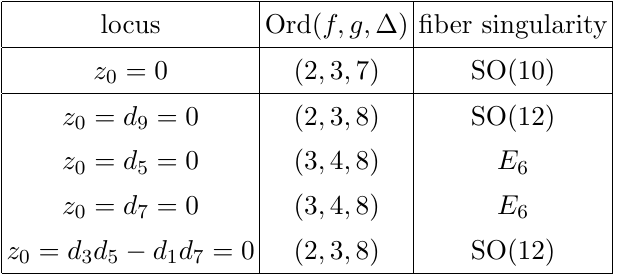
Table 3 . Codimension-one and codimension-two singularities of the CY twofold and the associated symmetry